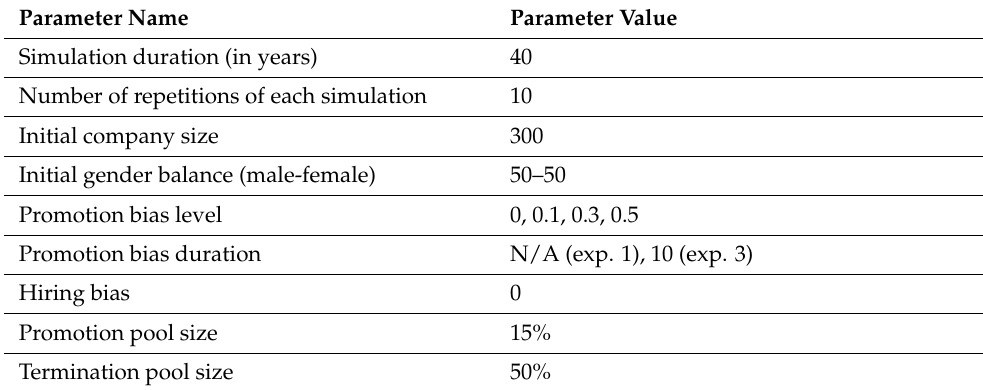
Table 2. Parameter settings for our promotion bias in Experiments 1 and